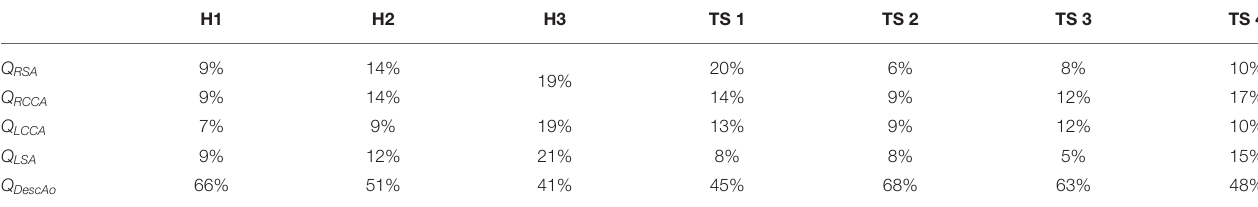
areas where flow departs from a laminar, unidirectional